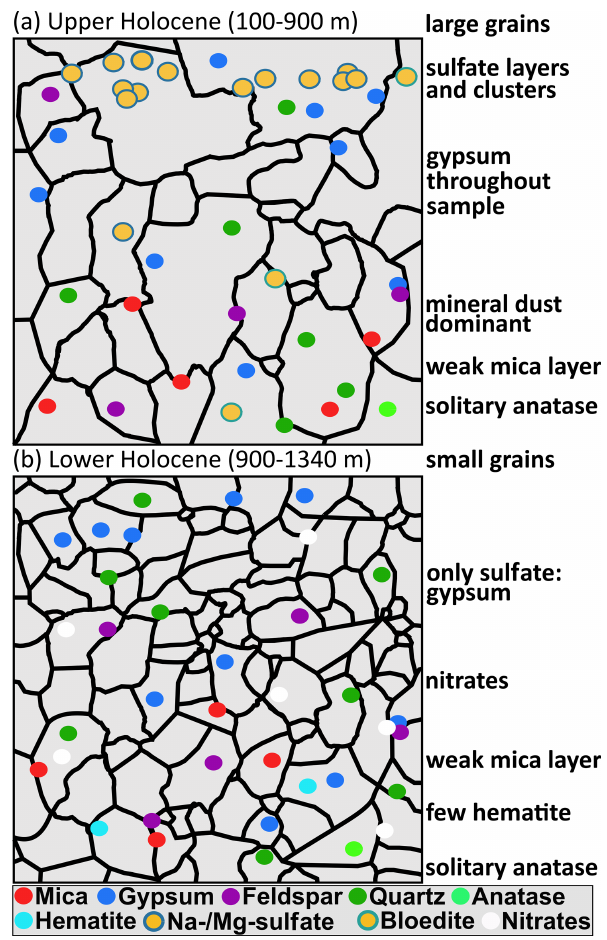
Figure 9. Sketch of the simplified distributional patterns of minerals found in (a) upper Holocene ice and (b) lower Holocene